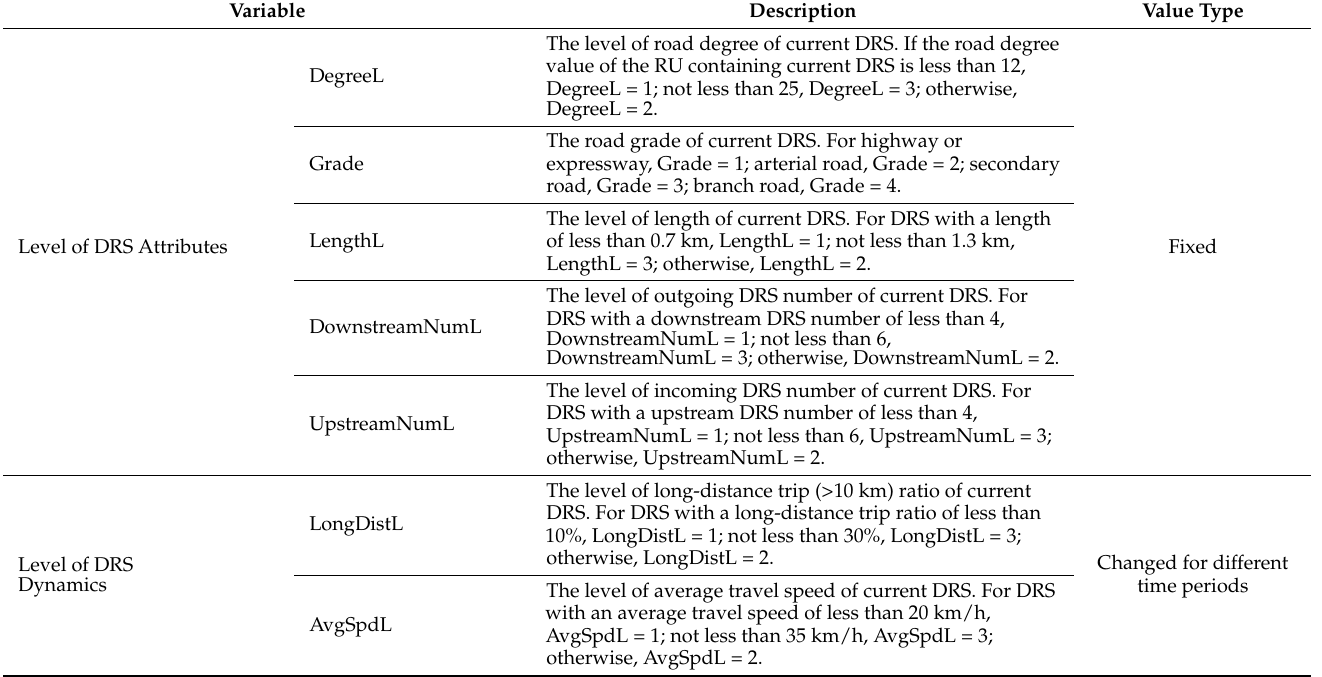
Table 2. DRS-correlated variable description and classified